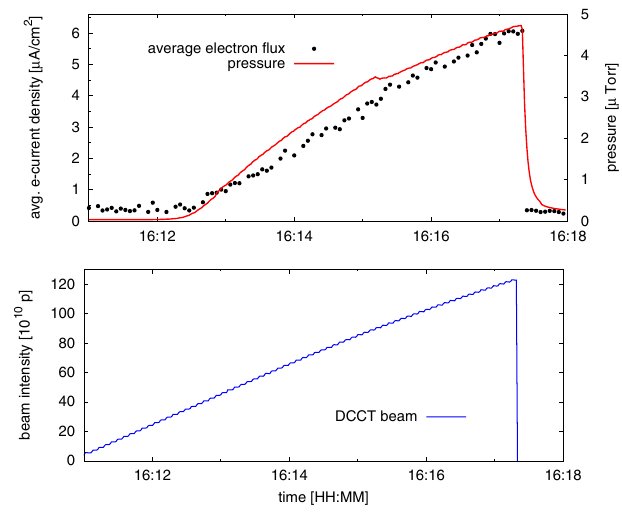
FIG. 9. (Color) Measured pressure and time-averaged electron current density into the wall (top), as Blue beam is being injected (bottom)